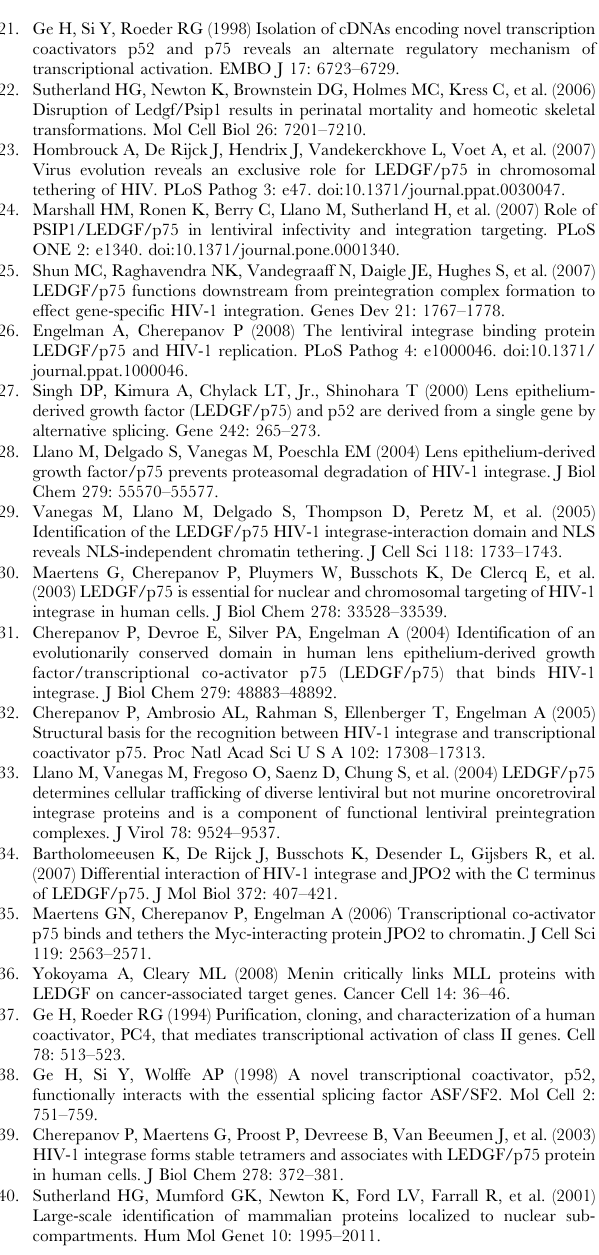
Table S1 Peptide array quantification values of all 59 histone modifications. Cells highlighted with yellow are with specificity factor . 2, and were used to generate Figure 1C. Table S2 Alternative splicing array results in Excel spread sheets (Sheet 1 includes data from all the exons on the array, Sheet 2 includes only exons which shows significant changes in alternative splicing between wild-type and Psip1gt/gt cells, Sheet 3 includes the annotation for the data. Related to Figure 5. Table S3 Sequence of PCR primers used for RT-PCR validation of alternative splicing events in wild-type, Psip1 gt/gt , and Psip 2 / 2